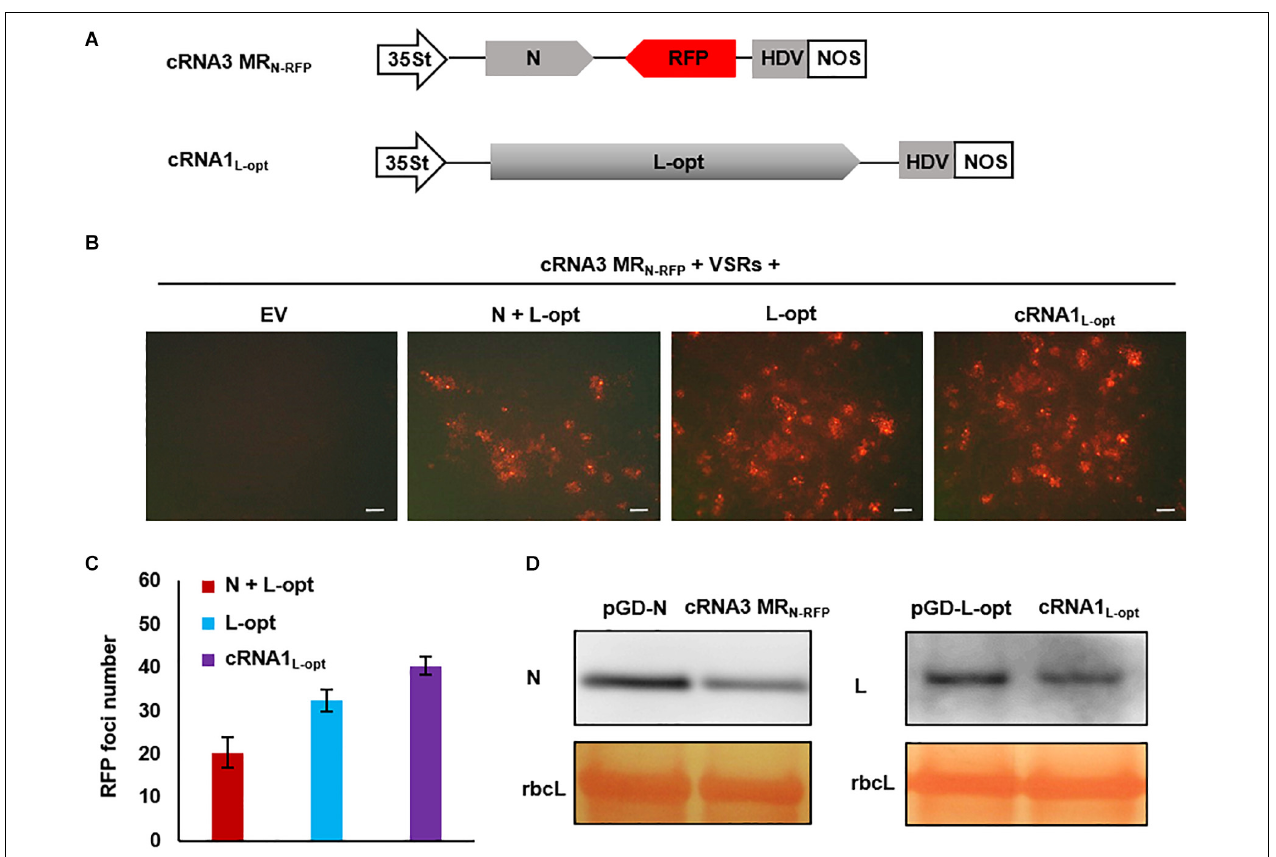
FIGURE 6 | Development of an autonomous minireplicon (MR) system without the need of the N and L expression plasmids. (A) Schematic representations of the binary constructs designed for transcription of cRNA3 MR N − RFP and cRNA1 L − opt . The cRNA3 MR N − RFP construct contains a red fluorescent protein (RFP) gene substituted for the NS3 coding region in the complementary-strand of RNA3, and the cRNA1 L − opt plasmid encodes the codon-optimized L protein sequence (L-opt). (B) Visualization of RFP expression in N. benthamiana leaves agroinfiltrated to express the N and L-opt proteins, the L-opt protein alone, cRNA1 L − opt , or an empty binary plasmid (EV). Infiltrated leaves were photographed at 8 dpi with a fluorescence microscope. Scale bar = 200 µ m. (C) Quantitative analyses of the number of RFP foci per field in infiltrated leaf tissues. The data show the means of six independent micrographs ( n = 6), and the error bars denote standard deviation ( ± SD). (D) Comparison of the expression levels of N and L in infiltrated leaves. Total protein was extracted from agroinfiltrated leaves with the indicated constructs in the presence of viral suppressor of RNAs (VSRs) at 2 dpi and detected with N- and L-specific antiserums. The large RuBisCO (rbcL) subunit was stained by Ponceau S to visualize protein